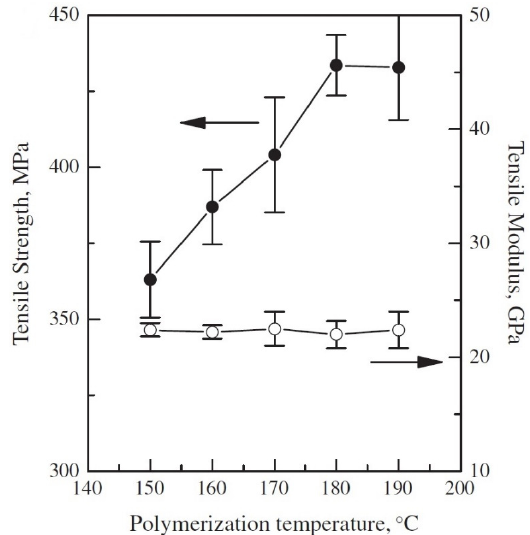
Figure 16. Effects of polymerization temperature on the mechanical properties of GF/APA-6 compos- ites. Adapted from Reference [86], under open-access